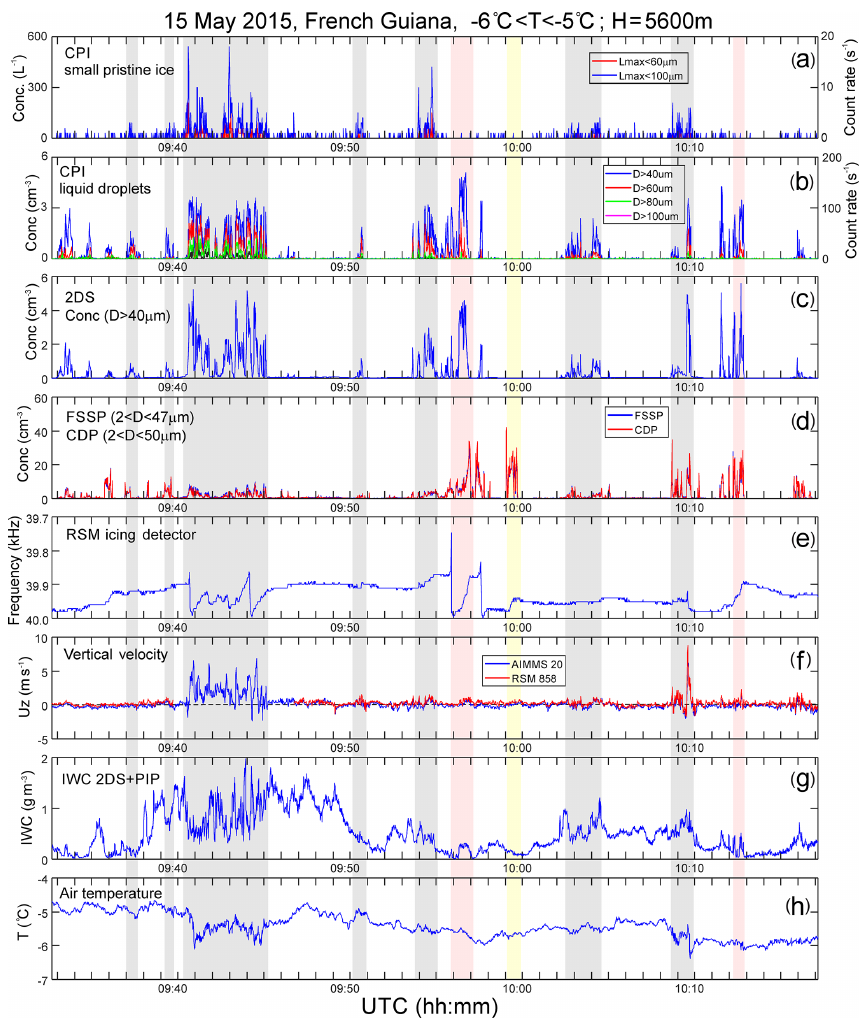
Figure 5. Time series of microphysical parameters collected in oceanic MCS offshore French Guiana on 15 May 2015. (a) CPI count rate of small pristine ice with L max < 60 and 100µm; (b) CPI count rate of cloud droplets with D > 40, 60, 80, and 100µm; (c) concentration of cloud particles D > 40µm measured by 2DS; (d) concentration of cloud droplets measured by FSSP and CDP; (e) Rosemount icing detector frequency; (f) vertical velocity measured by AIMMS20 and Doppler velocity calculated from W-band radar; (g) IWC calculated from 2DS and PIP; (h) air temperature. Grey strips indicate cloud regions with enhanced concentration of small faceted ice particles; red and yellow strips indicate regions where ice and liquid were present, but no SIP was observed (see text). The altitude of measurements varied between 5600 and